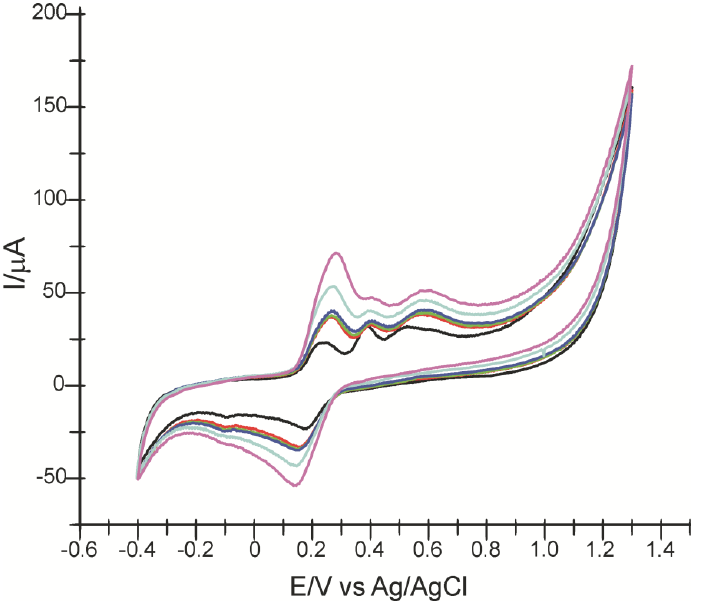
Figure 6. Cyclic voltammograms of CNF/SPE in FA 10 − 3 M solution (black line), then containing different CA concentrations: 10 μ M (red line), 50 μ M (green line), 100 μ M (blue line), 500 μ M (light blue line) and 1000 μ M (purple line).